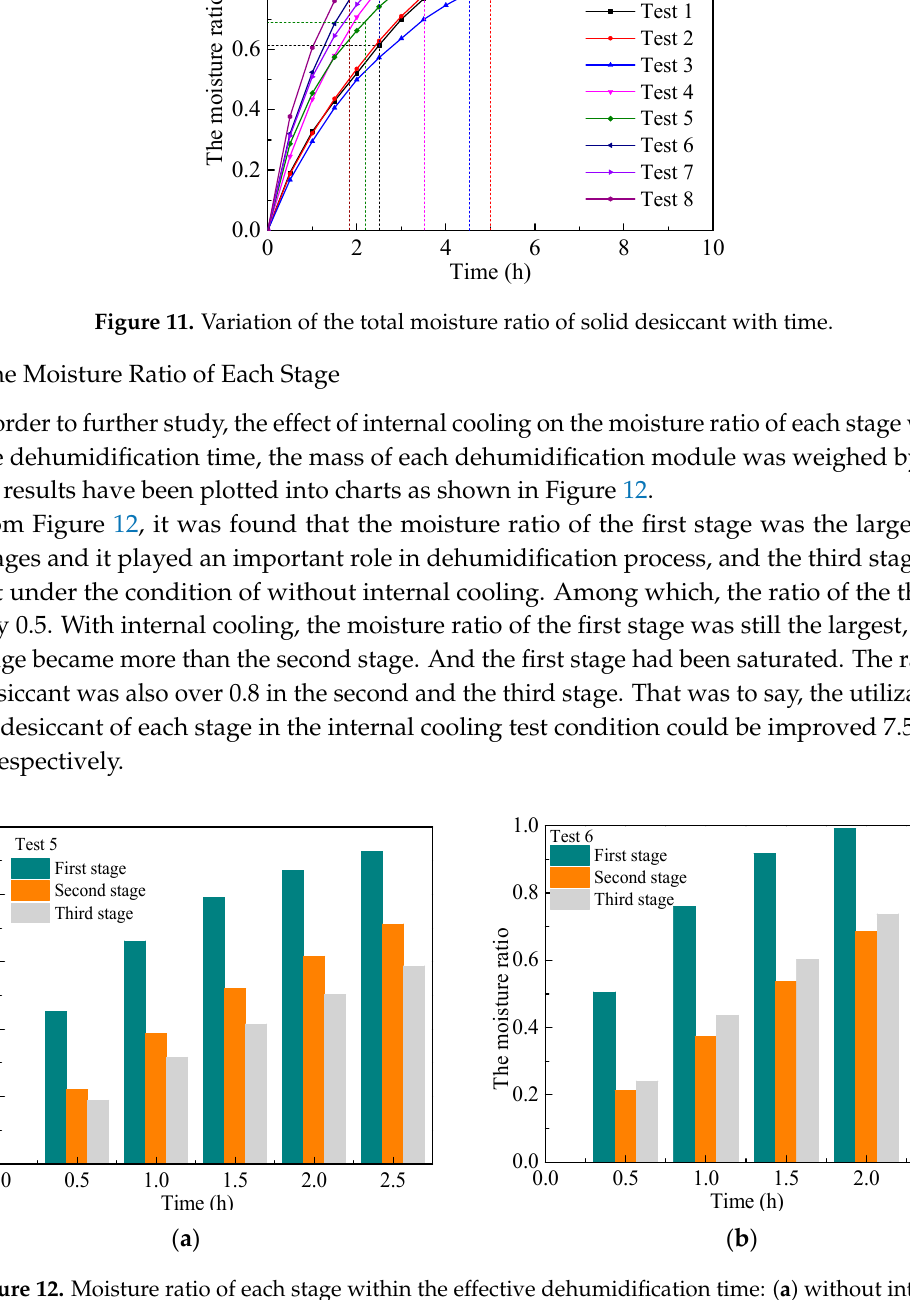
Figure 12. Moisture ratio of each stage within the effective dehumidification time: ( a ) without internal cooling; ( b ) with internal cooling.